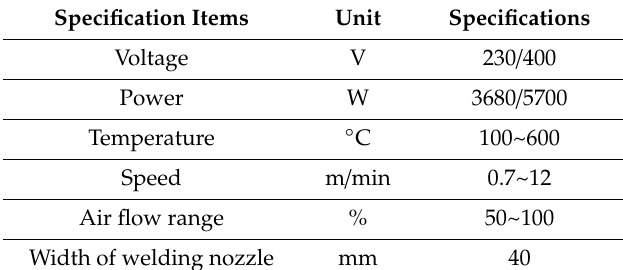
Table 5. Material information for fabrication of test specimens.